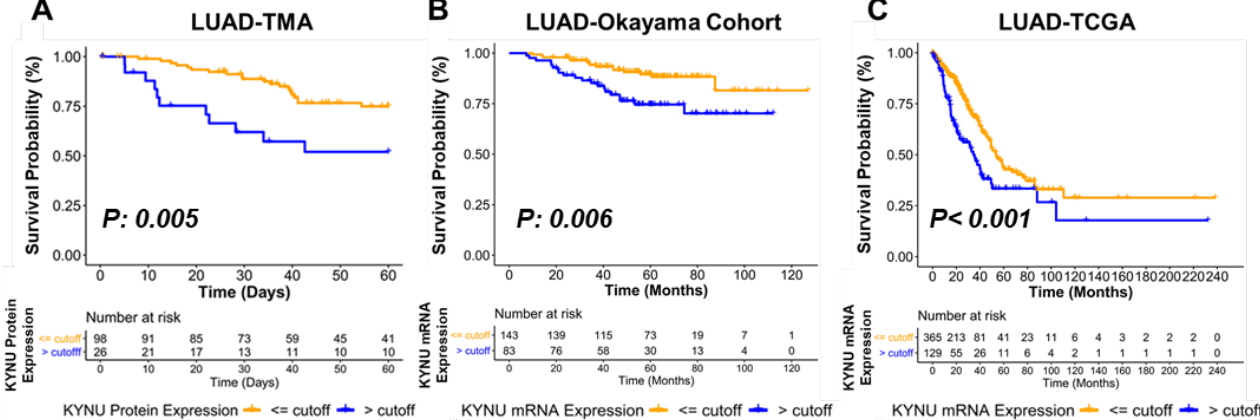
Figure 4. Association between KYNU and overall survival in LUAD. ( A ) Kaplan – Meier survival curves for five-year overall survival in adenocarcinoma TMAs based on a KYNU staining positivity cutoff of > 120. Optimal cutoff value Figure 4. ( B , C ) Kaplan – Meier survival curves depicting overall survival in LUAD tumors stratified by an optimal cutoff value for KYNU mRNA Okayama and TCGA-LUAD gene expression datasets. Statistical significance was determined by two-sided log-rank Mantel – Cox test. Table 1. Cox proportional hazard models for KYNU protein expression and overall survival in lung adenocarcinoma TMA.